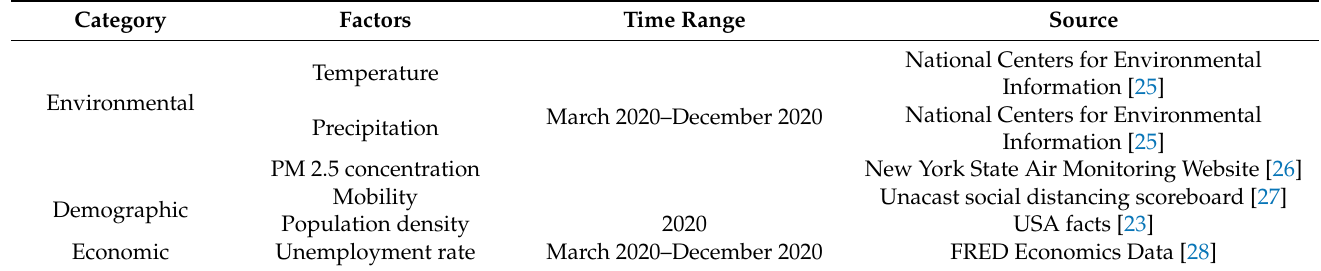
Table 1. Influencing factors used in this